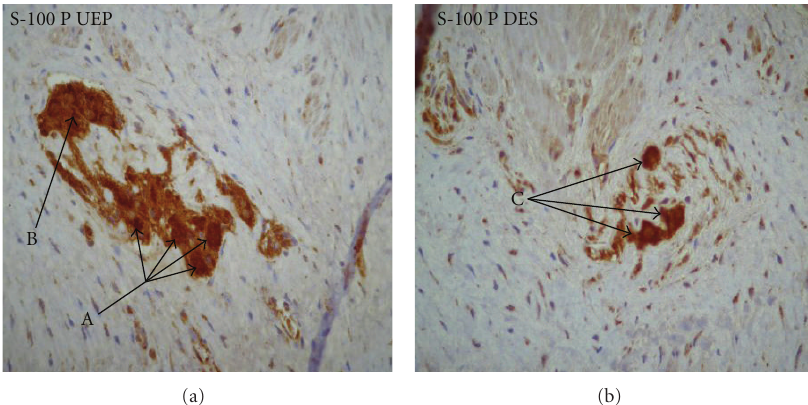
Figure 2: S-100 Protein (S-100). (a) The UEP shows fewer ganglion cells in the myenteric plexus (A) and an increased immunoreactivity for S-100 (B) than the control; (b) The DES shows few small immature cells (C) with less marked immunostaining than in the UEP.